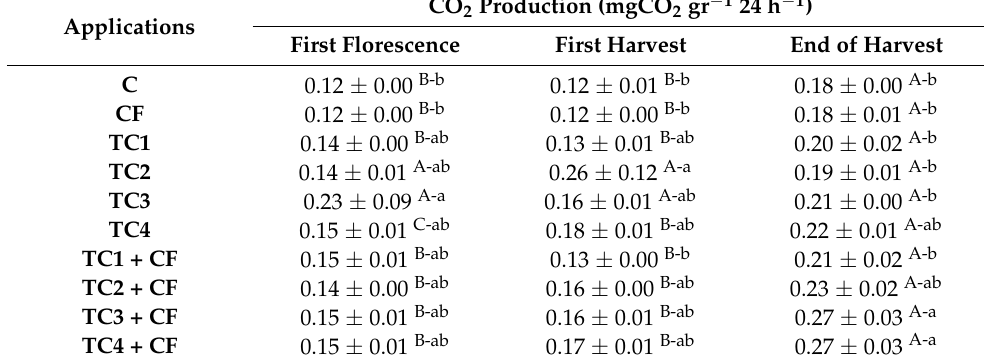
Table 4. CO 2 production